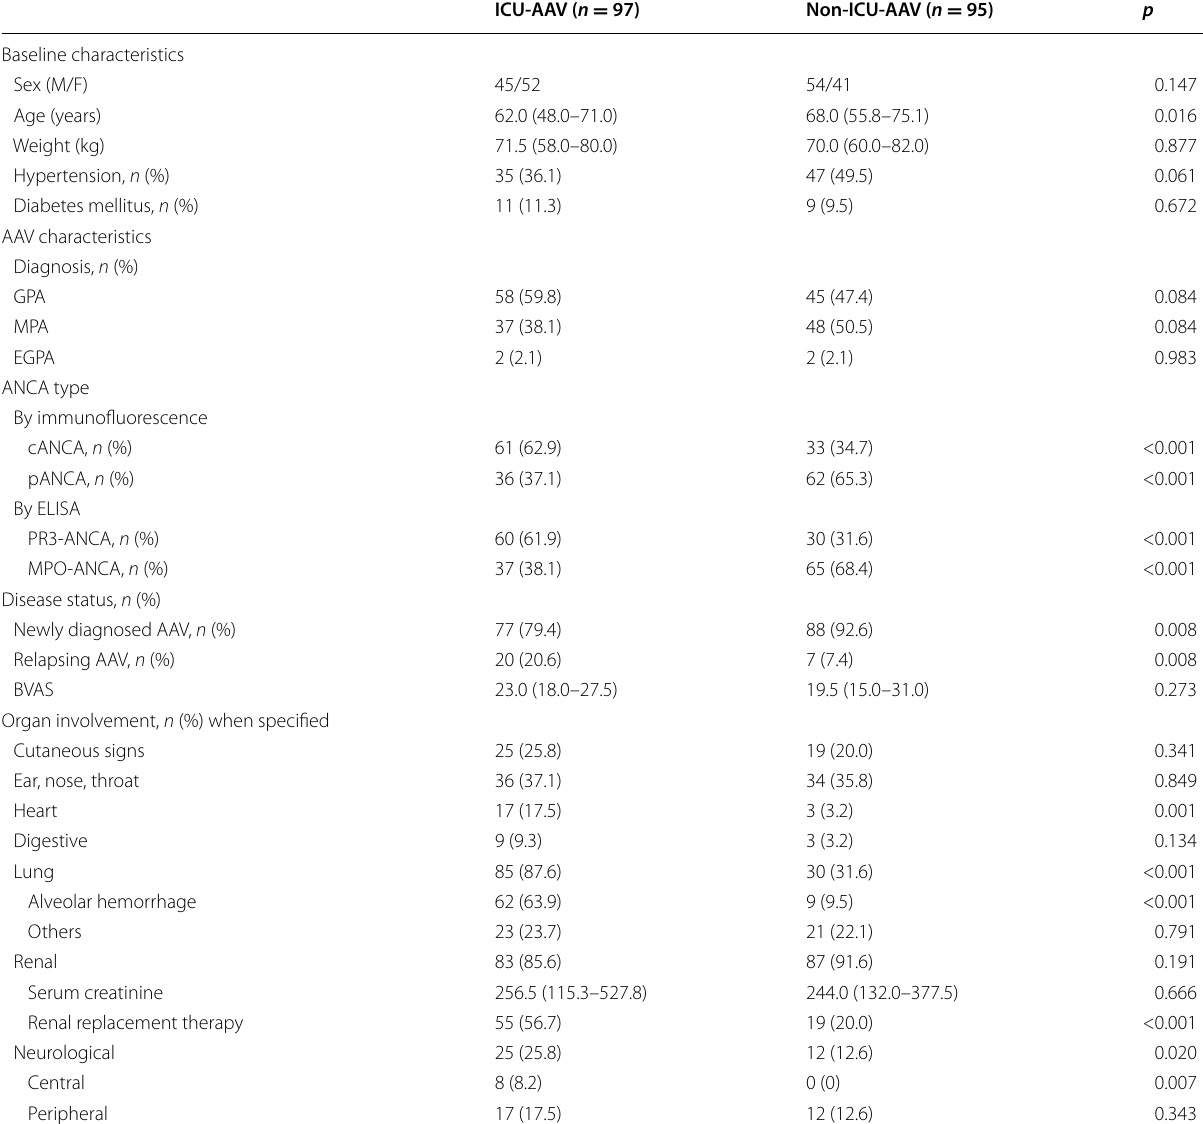
Table 1 Baseline characteristics of the ICU and non-ICU ANCA-associated vasculitis